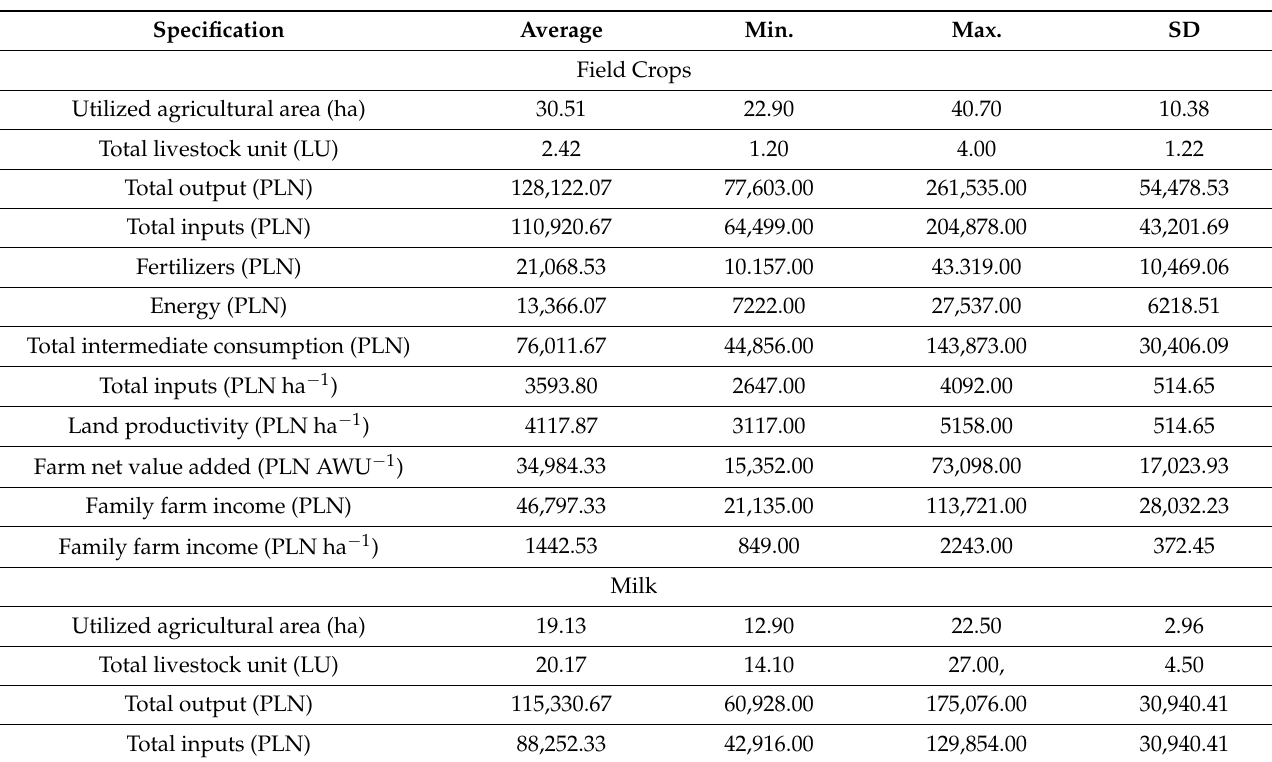
Table A2. Descriptive statistics of